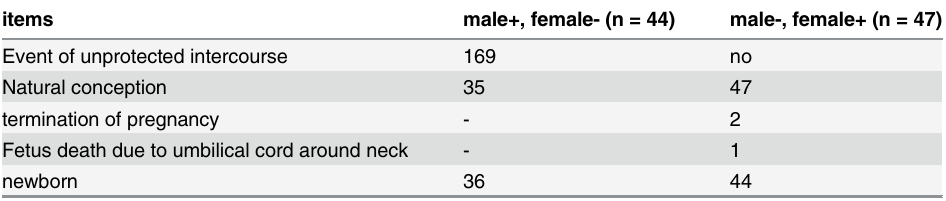
Table 3. Natural pregnancy outcomes of HIV-discordant